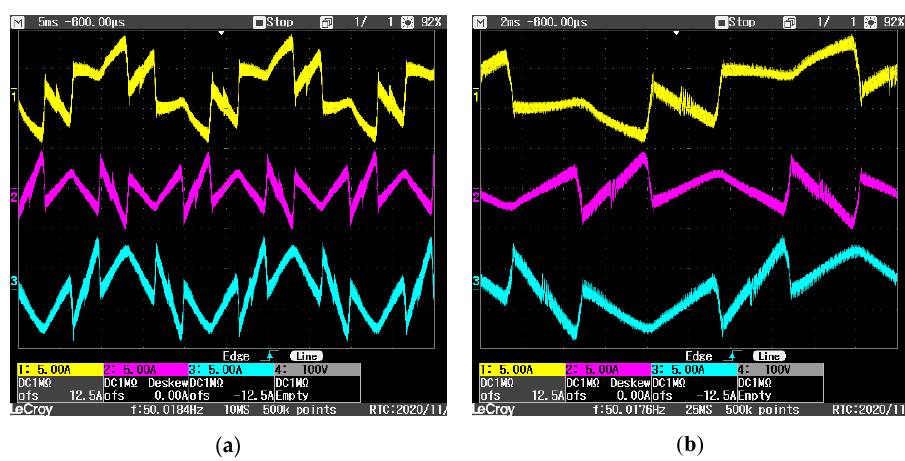
Figure 18. SAPF phase current waveforms ( a ) and a detail at 2 ms/div ( b ). Electronics 2020 , 9 , x FOR PEER REVIEW